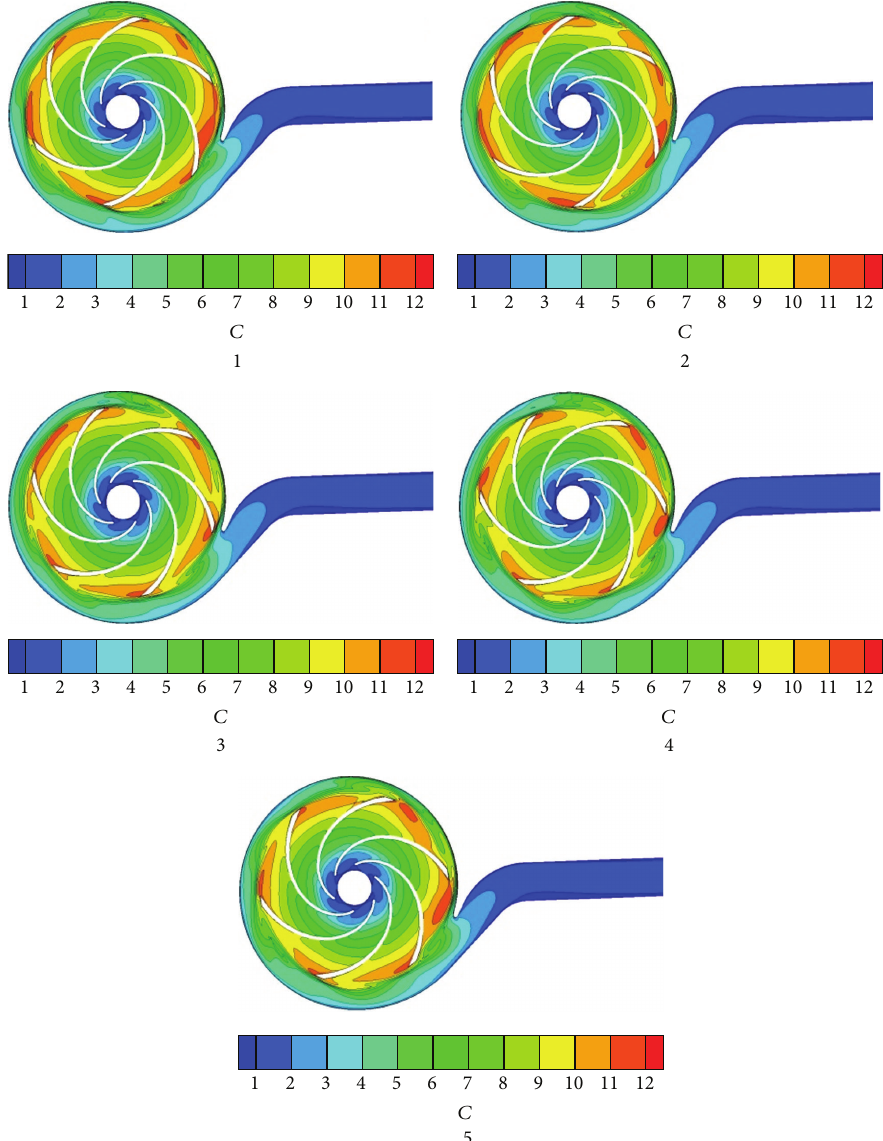
Figure 12: Absolute velocity distribution at 0.6 𝑄 𝑑